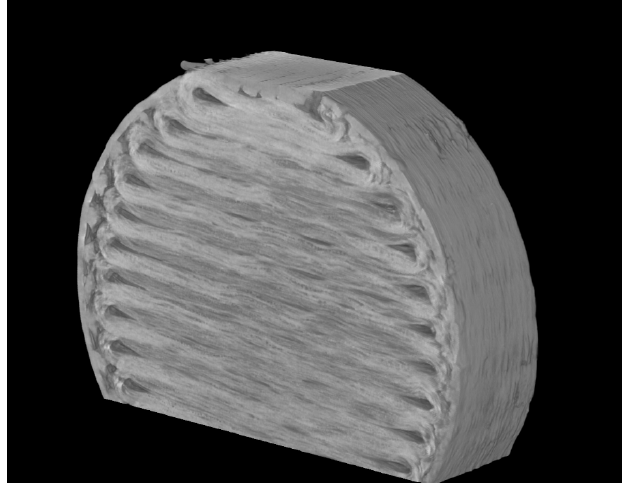
Figure 14. Micrograph of a through-thickness sample showing the layer path and the void distribu- tion.